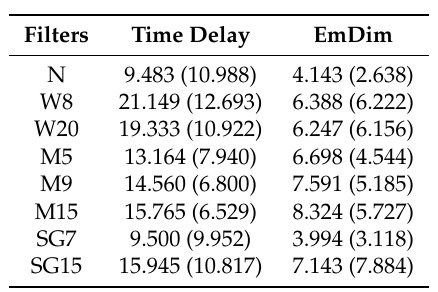
Table 1. Estimations of the time delay and embedding dimension, averaged over all time series. Standard deviations are placed in